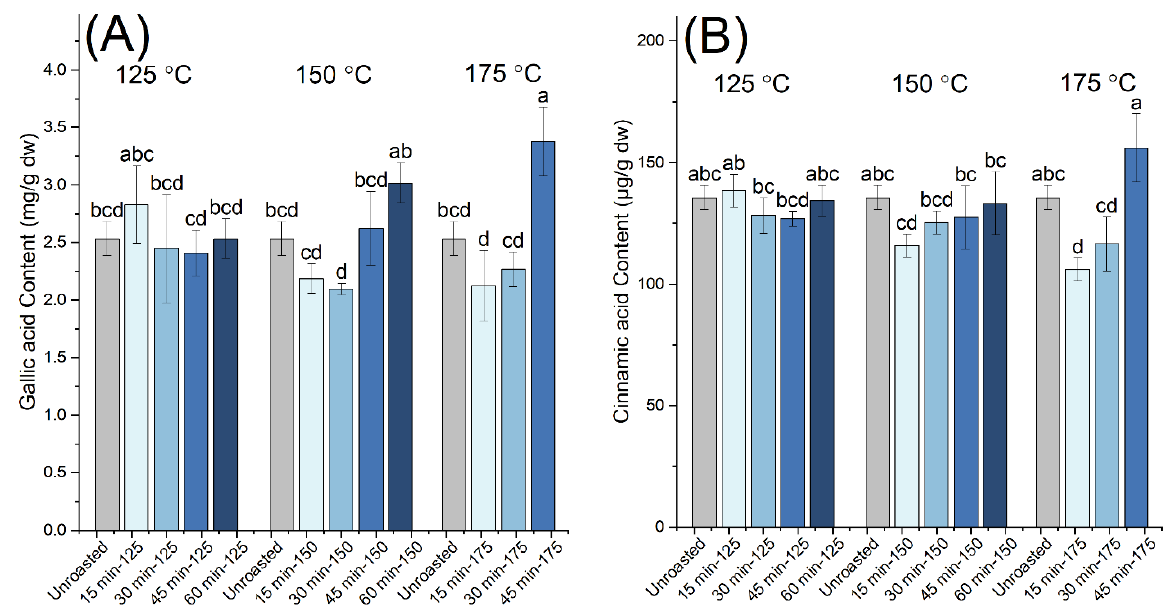
Figure 3. ( A ) Gallic acid and ( B ) cinnamic acid contents of the carob powder extracts obtained prior to (unroasted) and after the roasting of kibbles at 125 °C (for 15, 30, 45 and 60 min), 150 °C (for 15, 30, 45 and 60 min) and 175 °C (for 15, 30 and 45 min). The different letters show the statistically significant differences according to Tukey’s HSD test at p < 0.05.